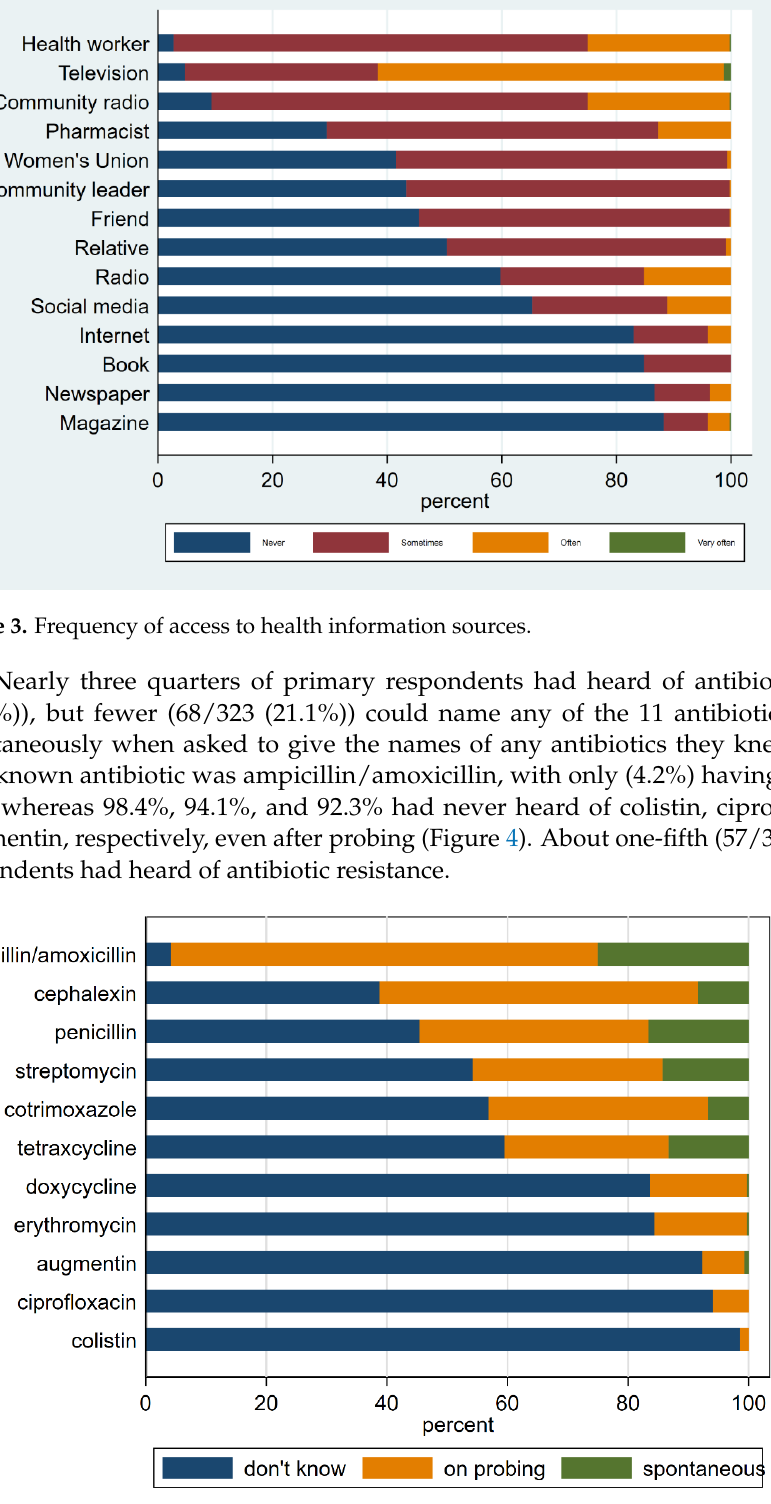
Figure 2. Frequency of media use ((SMS = Short Message Service).